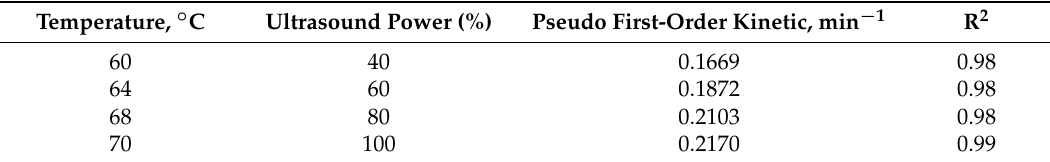
Table 4. Kinetic analysis of the transesterification